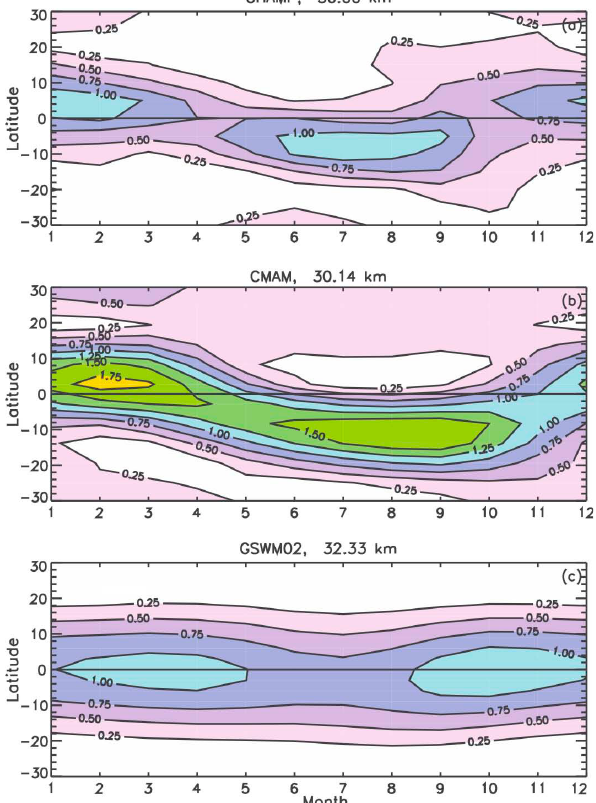
Fig. 13. ( a top) Height-time series of deseasonalized temperature anomalies over the equator (4 ◦ N to 4 ◦ S) derived from GPS/MET data. Contours are +/ − 0.5, 1.5, 2.5,.... K. Heavy line is cold point tropopause. Downward propagating patterns over the depth of the stratosphere with an approximate 2-yr periodicity reflect the strato- spheric QBO (Randel et al., 2003). ( b bottom) same as (a) above but for 5 ◦ N to 5 ◦ S using CHAMP data (T. Schmidt, GFZ, personal communication, 2010).